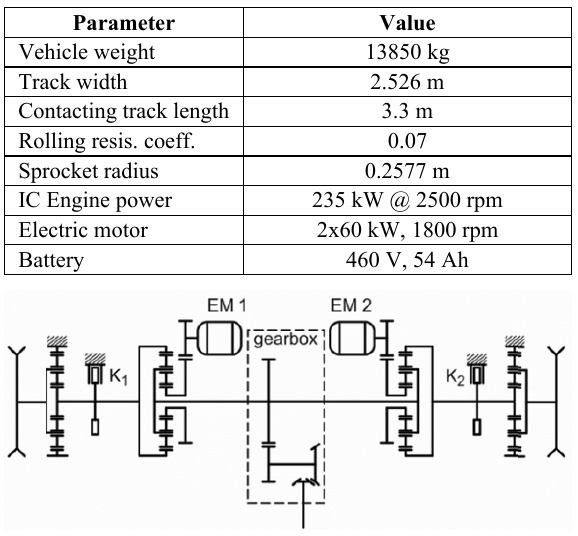
Figure 1. Kinematic scheme of hybrid drive system